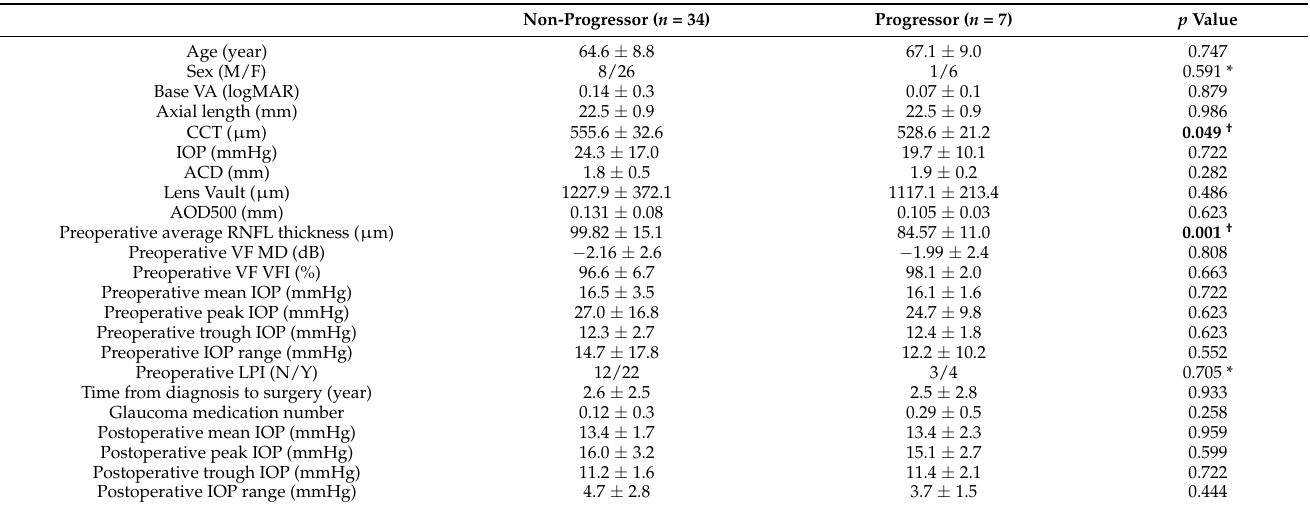
Table 2. Comparison of demographics and clinical characteristics in cases with and without progres- sion of structure with primary angle closure suspect and primary angle closure.